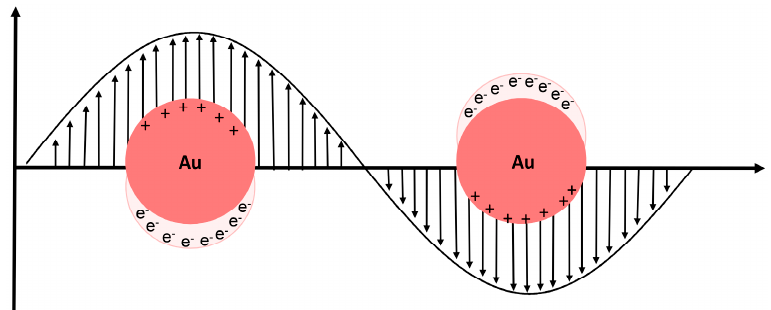
Figure 1. Schematic representation of metal nanoparticles in localized surface plasmon resonance (LSPR). Interaction of the electromagnetic waves with the metal nanoparticle (NP) surface electrons (e − ) induces a surface plasmon resonance.